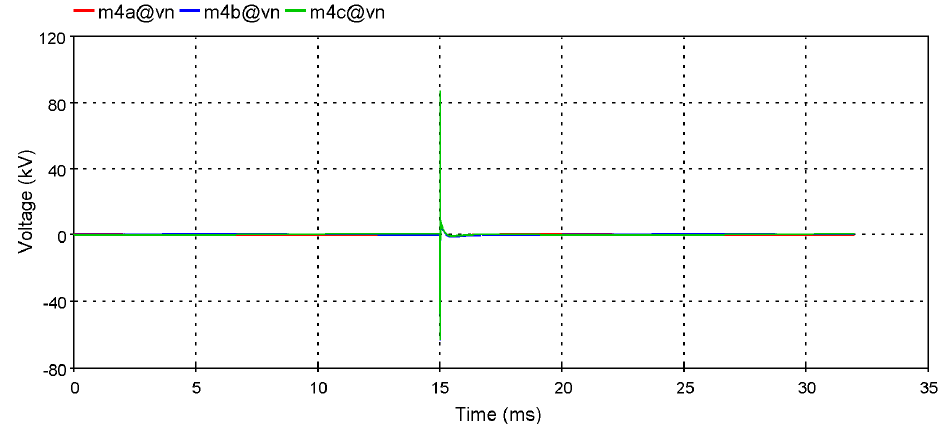
Figure 8. Overvoltage at the secondary side of the auxiliary